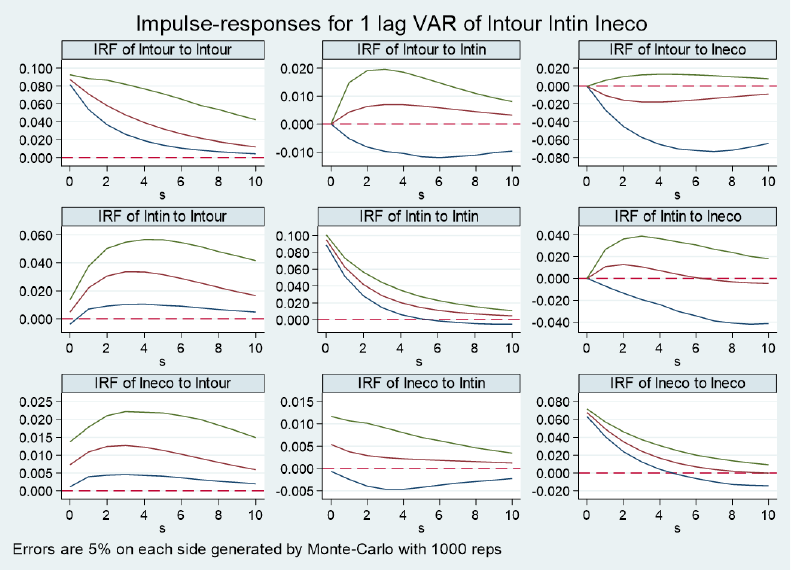
Figure 6. Impulse response analysis of less developed regions in the central and western regions in China. The red lines represent estimated impulse response value. The area between the green lines and blue lines is the confidence interval of 5% significance.